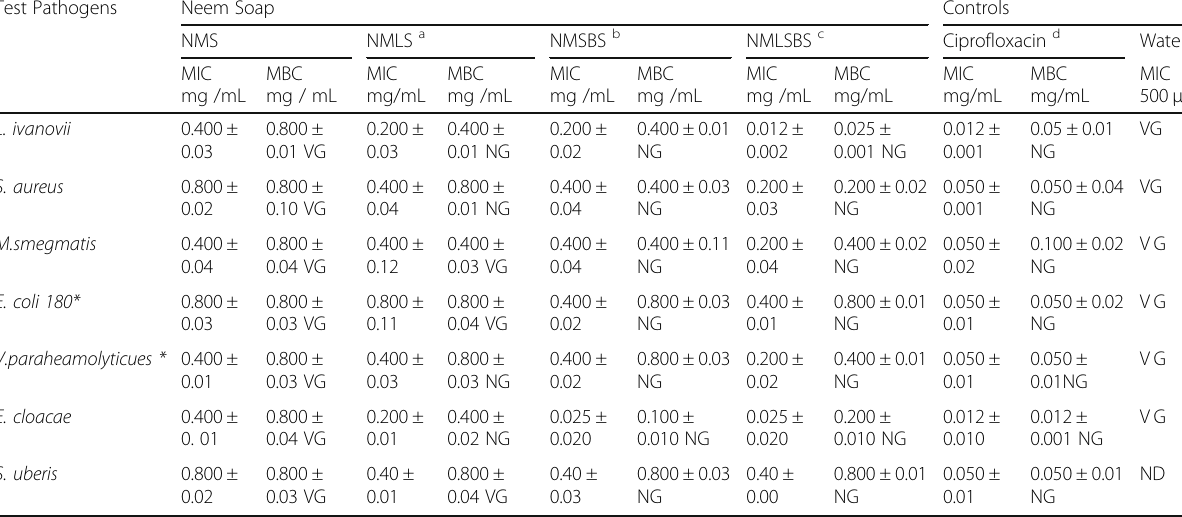
Table 3 Neem soap minimum inhibitory and minimum bactericidal concentrations (MIC and MBC) Test Pathogens